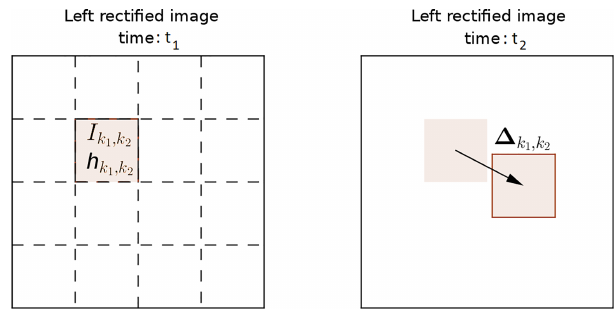
Figure 6. Multiblock tracking algorithm for cloud field velocity es- timation. For each block I k , the velocity vector is computed by 1 ,k 2 using the displacement vector (cid:49) k expressed in pixels and the 1 ,k 2 median altitude h k . Displacement vector is computed by using 1 ,k 2 the Lewis (1995)’s matching template algorithm. Computations are based on two successive rectified images: in our case we use the left rectified image at times t 1 and t 2